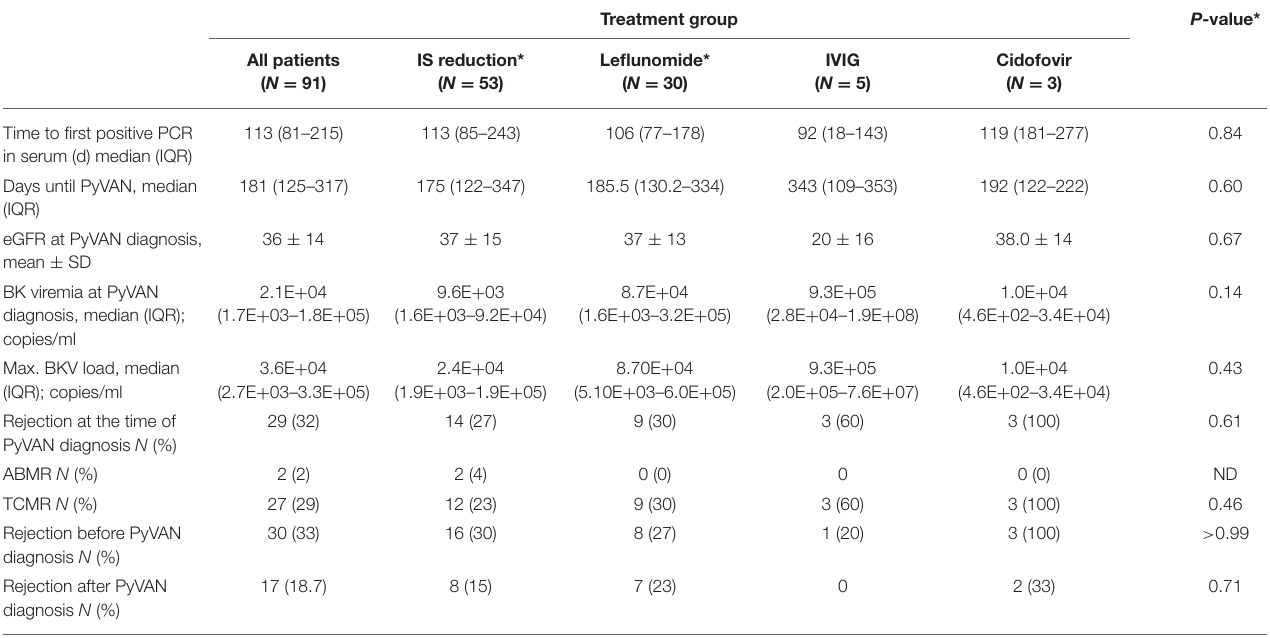
TABLE 2 | Polyomavirus associated nephropathy (PyVAN)-associated data of the study population.